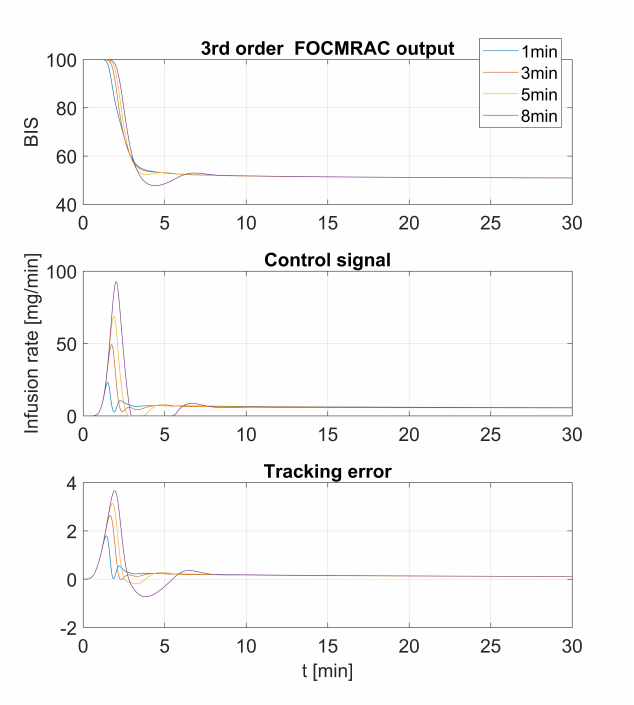
Figure 24. BIS response of patient 1 with different time delays using the 3rd-order FOCMRAC